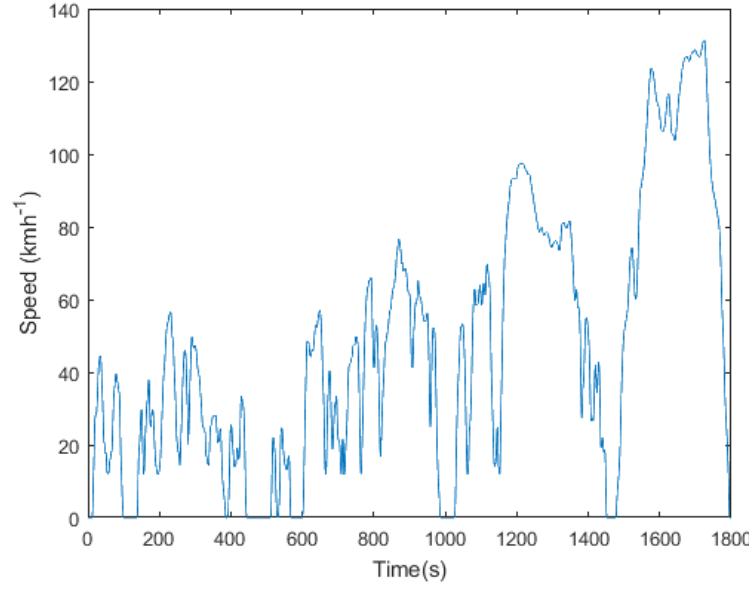
Figure 14. World harmonised Light Duty Test